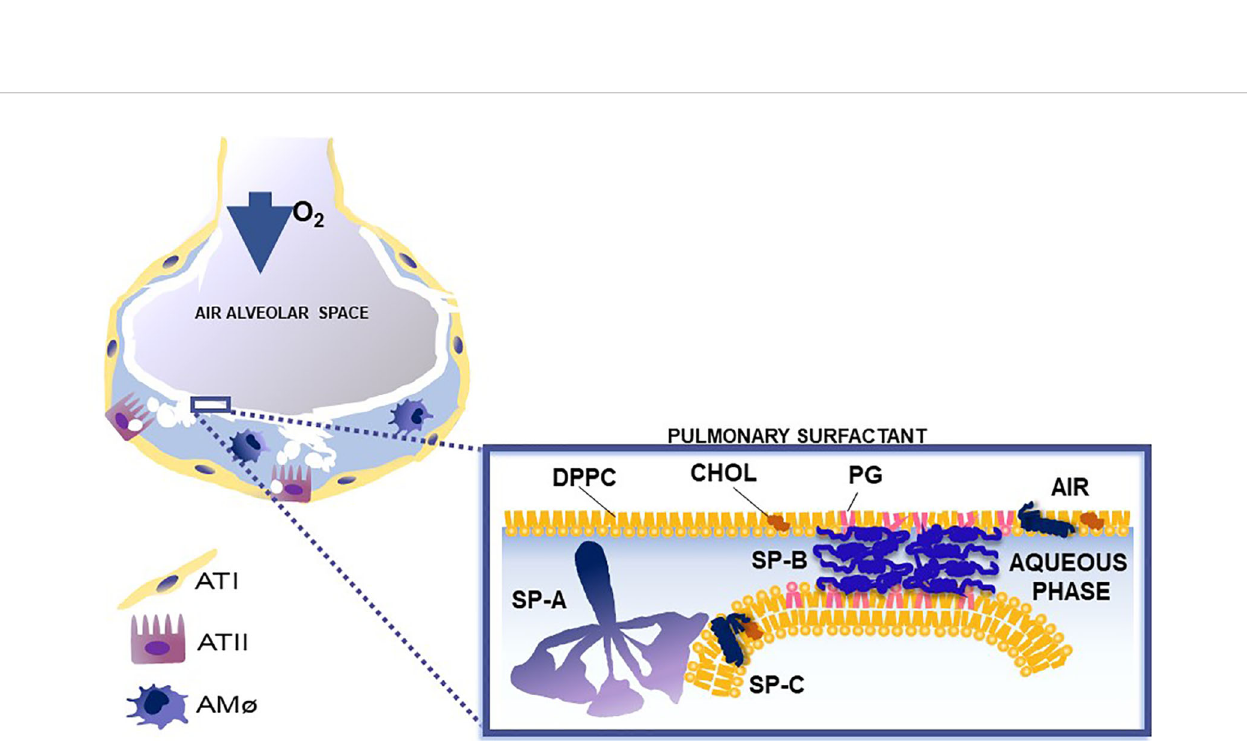
FIGURE 1 | Alveolus, surfactant function, and surfactant composition. (A) depicts a cartoon of the alveolus, which is lined by epithelial type II and type I cells with the alveolar macrophage in the hypophase. In (B) the top air/aqueous interface lacks surfactant phospholipids and this leads to an increase in surface tension ( g ). In the presence of phospholipids, the surface tension ( g ) is reduced (bottom panel) and this prevents alveolar collapse. (C) depicts the lipid and protein composition of pulmonary surfactant. Courtesy of Dr. Jesus Perez-Gil